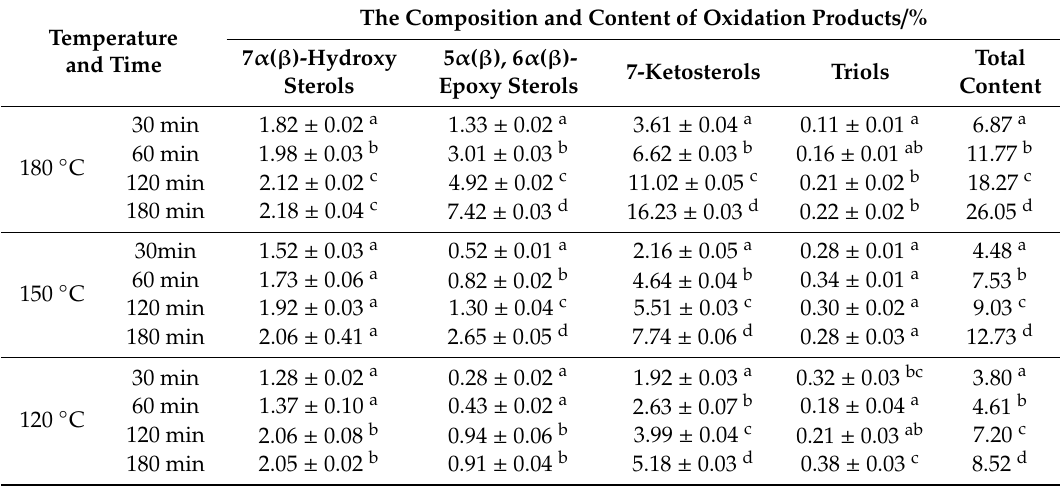
Table 1. The total content and composition of SGPs oxidation products in the non-oil system *. The Composition and Content of Oxidation Products / Temperature and Time